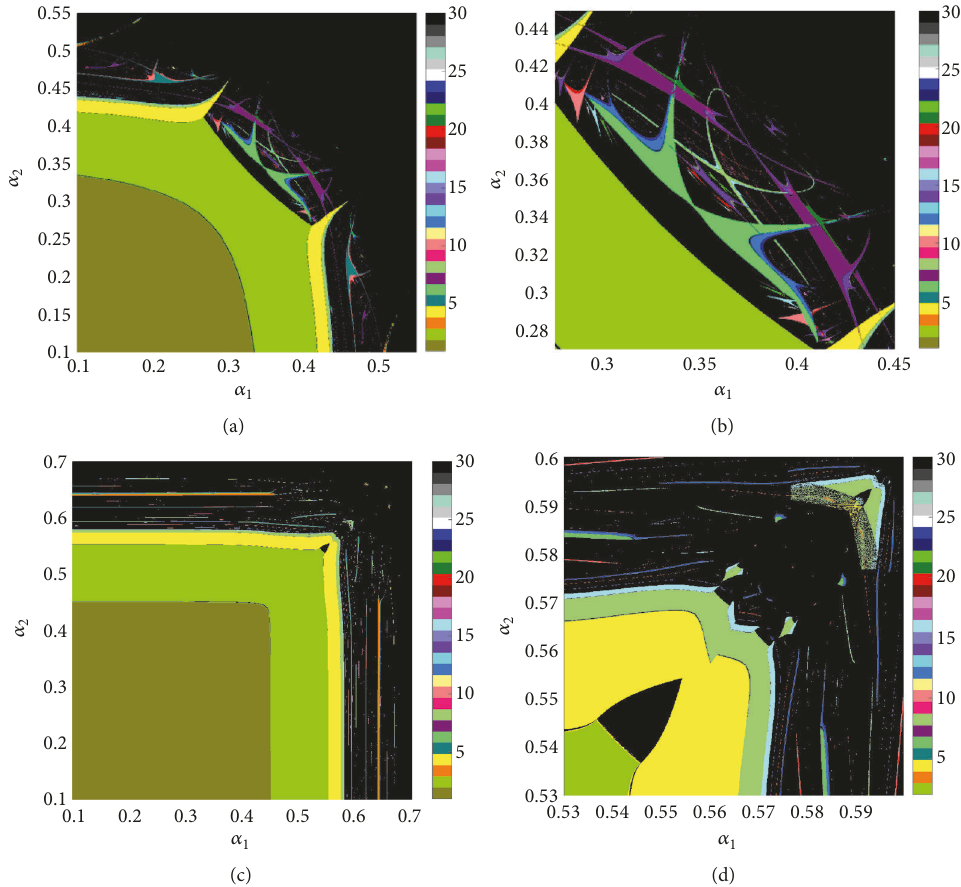
Figure 5: The two-parameter bifurcation diagram in the parameter plane (𝛼 1 ,𝛼 2 ) with fixed parameters as 𝑎 = 7.12 , 𝑏 = 0.024 , 𝑐 = 0.98 , and 𝛽 = 0.38 . (a) The two-parameter bifurcation diagram with 𝛾 = 0.1 . (b) Partial enlargement of (a). (c) The two-parameter bifurcation diagram with 𝛾 = 1.0 . (d) Partial enlargement of